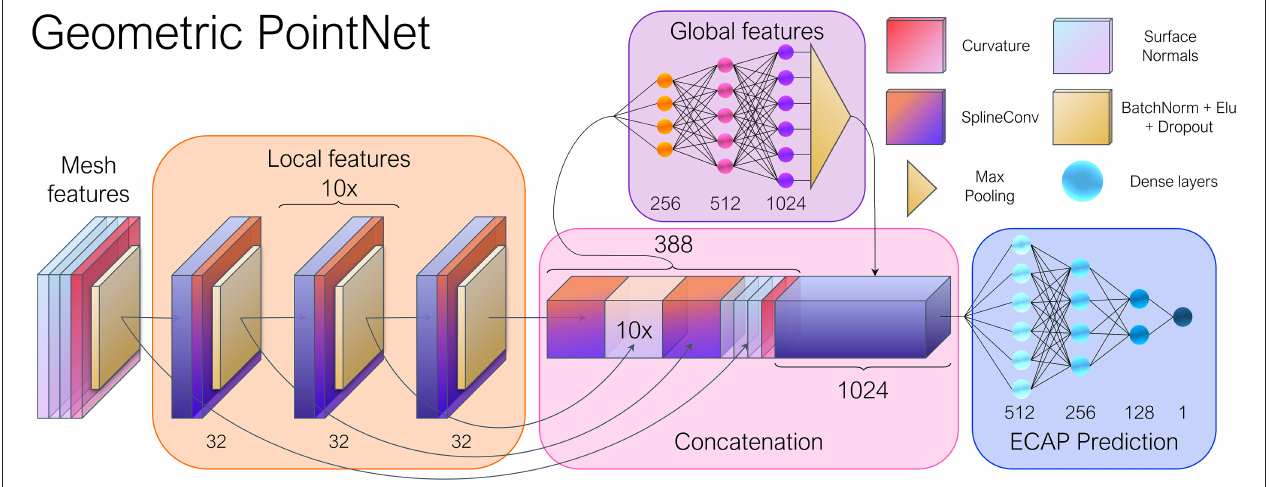
FIGURE 4 | General overview of the geometric deep learning network architecture. The input vertex features consisted of the point-wise curvature and normal vectors. The spatial relations between the nodes were stored as edge attributes through Cartesian pseudo-coordinates. Twelve consecutive SplineConv layers (Fey et al., 2018 ) were employed in the local feature module, while a 1,024 feature vector was obtained after max pooling, representing the global features of each mesh. Numbers adjacent to each layer indicate the number of output